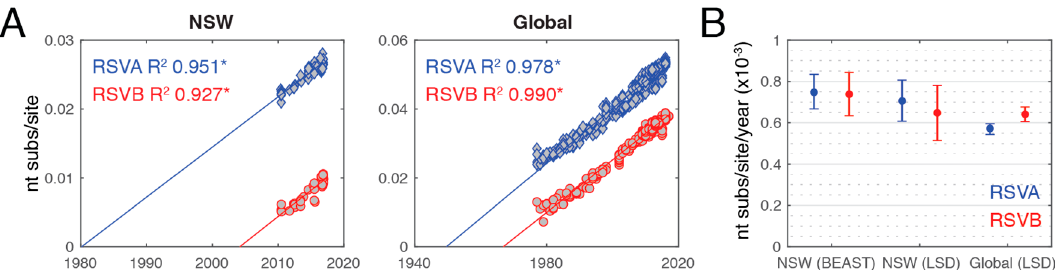
Figure 5. Evolutionary rates in respiratory syncytial virus (RSV). ( A ) Linear regressions of root ‐ to ‐ tip genetic distances against sampling date based on maximum likelihood trees. The R 2 value for each regression is indicated and corresponding p values <0.001 are indicated with an asterisk. Sequences from NSW in this study are shown on the left and global sequences on the right. ( B ) Estimates of the nucleotide substitution rate per site per year are shown for sequences from NSW (BEAST and least ‐ square dating algorithm (LSD) estimates) and globally (LSD estimates only). Rates are shown as mean values (circles) and the 95% highest posterior density (HPD) and confidence intervals for BEAST and LSD, respectively (error bar). (RSVA: blue; RSVB: red).